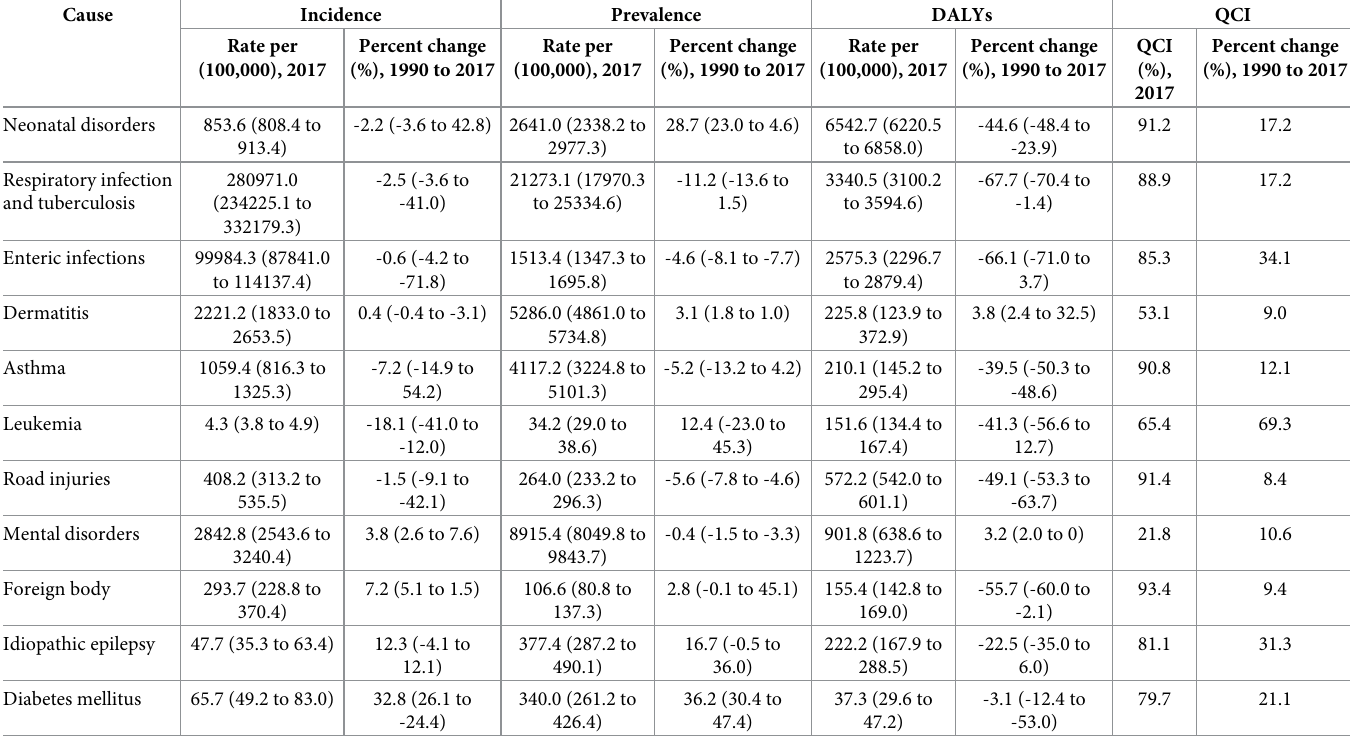
Table 1. Incidence, prevalence, DALY and QCI score in 2017, and its percent changes between 1990 and 2017 in 11 causes.